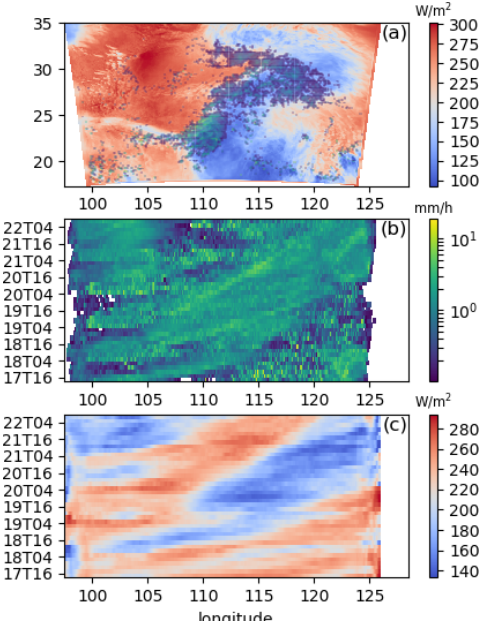
Figure 1. (a) The time-averaged multi-model mean outgoing flux of long-wave radiation (red-blue) and precipitation (green) at the top of the atmosphere between 00:00 and 06:00UTC on 20 May 2016. The averages are calculated from hourly instantaneous fields; precipitation rates less than 1mmh − 1 are excluded from the time averaging. (b, c) Hovmöller plots of meridionally averaged surface rainfall rate, (b) , and outgoing long-wave radiation (c) . Grid-points with precipitation rates less than 0.1mmh − 1 are excluded from the Hovmöller plot mean shown in (b)